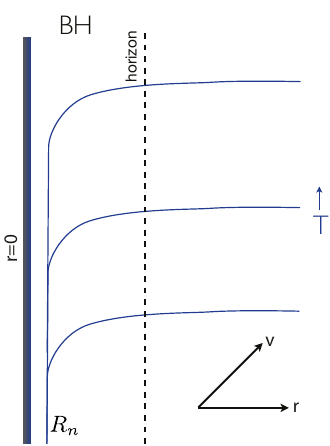
Figure 1 . An Eddington-Finkelstein diagram of a BH, with a family of slices, labeled by T , that smoothly cross the horizon. The case shown is that of \nice" slices, which asymptote to an internal radius R n ; one may alternately consider \natural" slices which intersect the strong-curvature region near r =